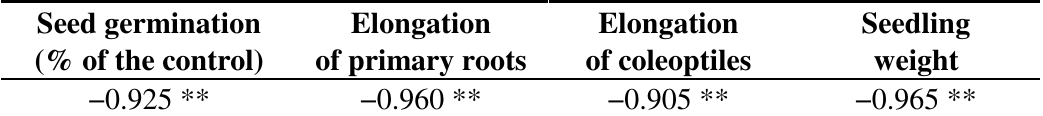
Table 1. Values of Pearson’s correlation coefficient calculated between tested juglone concentrations and recorded parameters of maize growth and development. ** p <